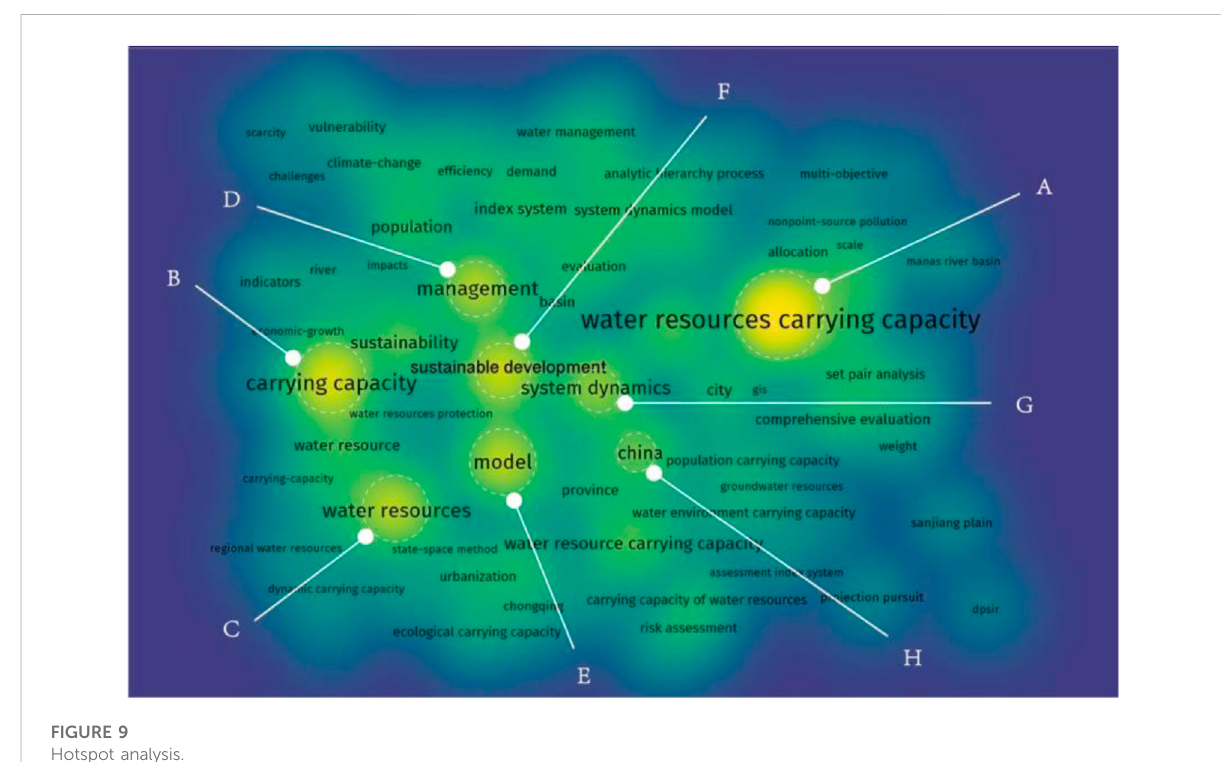
FIGURE 9 Hotspot